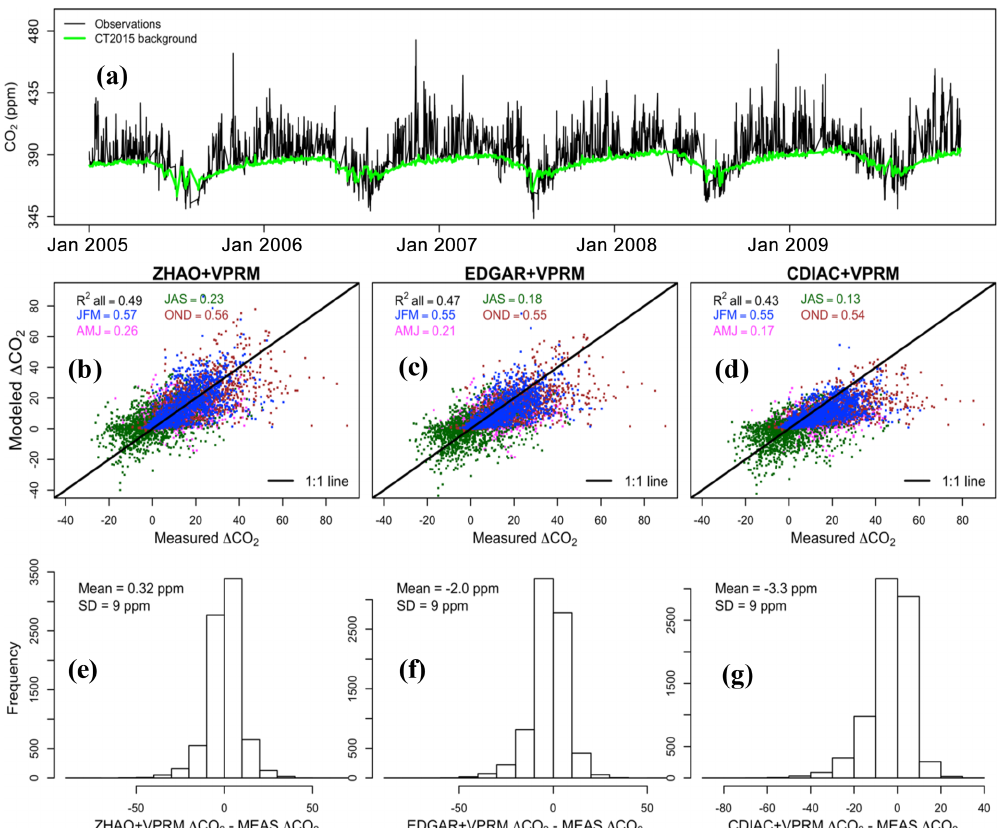
Figure 3. Hourly (11:00 to 16:00LT) modeled and measured CO 2 and (cid:49) CO 2 . Measured CO 2 and modeled CT2015 background concen- trations are displayed in (a) . Modeled versus measured (cid:49) CO 2 for each anthropogenic inventory is shown in (b) – (d) , colored by season. Histograms of modeled and measured residuals are shown in (e) – (g) . The VPRM vegetation component is included in all modeled (cid:49) CO 2